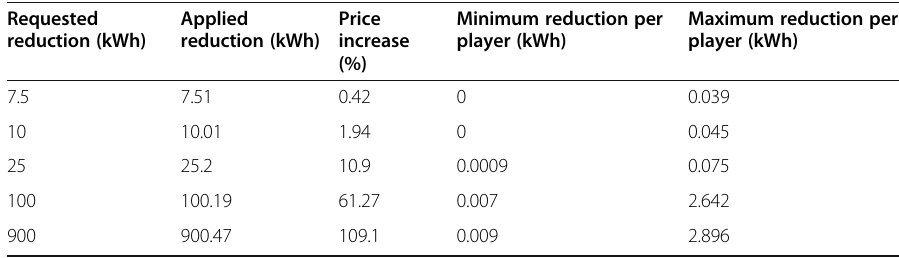
Table 3 Studied load response reductions